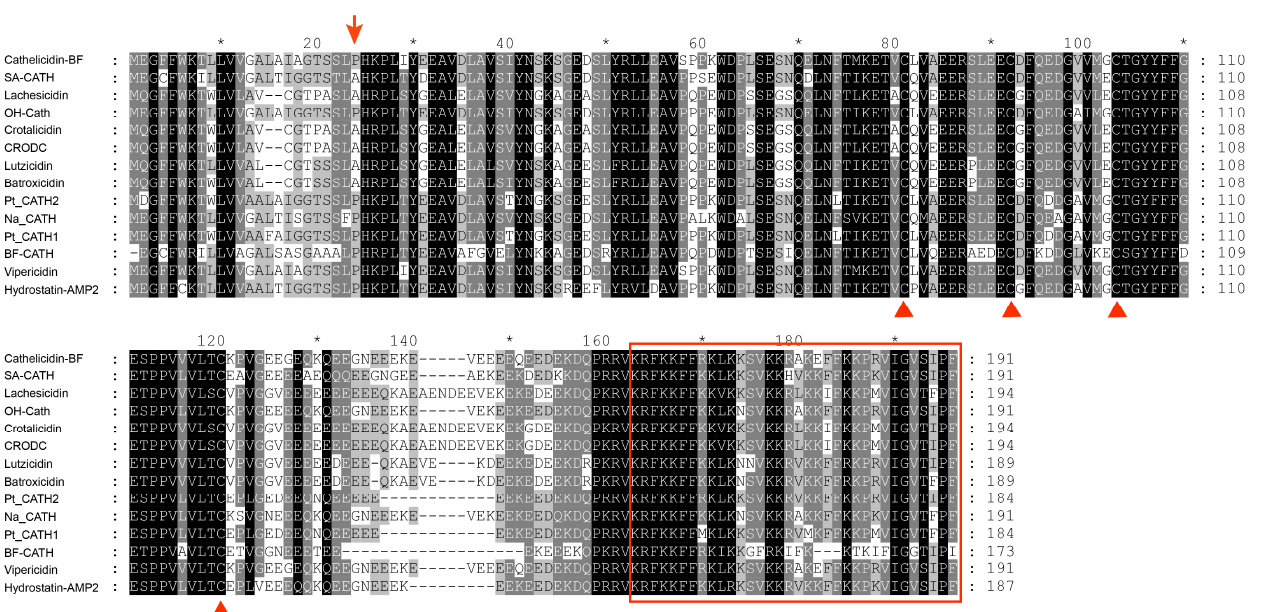
Figure 2. Multi-sequence alignment of Hydrostatin-AMP2 with other snake Cathelicidins. Sequences retrieved from NCBI were multi-aligned with Clustal Omega. Dashes were inserted to optimize the alignment. Highly conserved residues were shaded and identical residues were indicated in black. Arrows indicated the boundary between the signal region and the cathelin domain. The four cysteine positions at the end of the cathelin domain were indicated by triangles. The C-terminal region (mature peptide) where the antimicrobial activity resides was boxed.